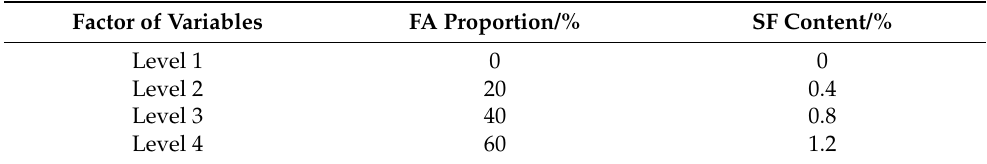
Table 3. Proportioning variable factors and